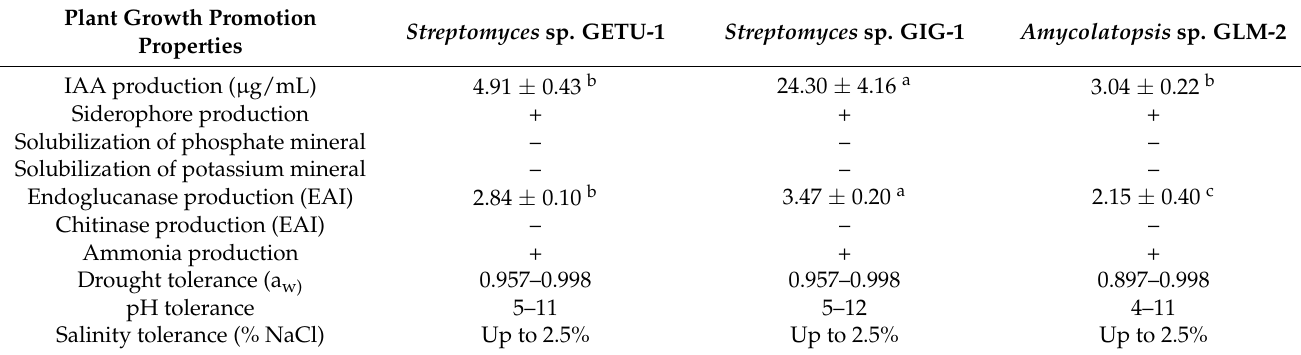
Table 3. Plant growth promotion properties of actinobacteria in this